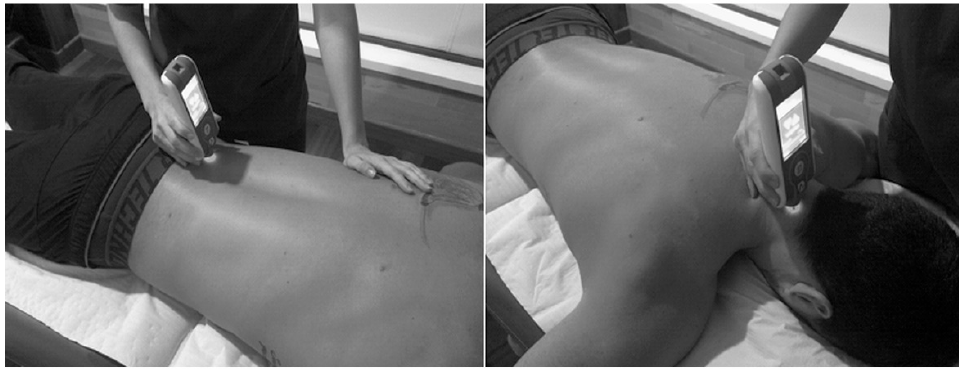
Figure 1. Procedure for measuring lumbar ( left ) and cervical ( right ) muscles using MyotonPro©. The evaluation was repeated 5 min later following the same process for the first